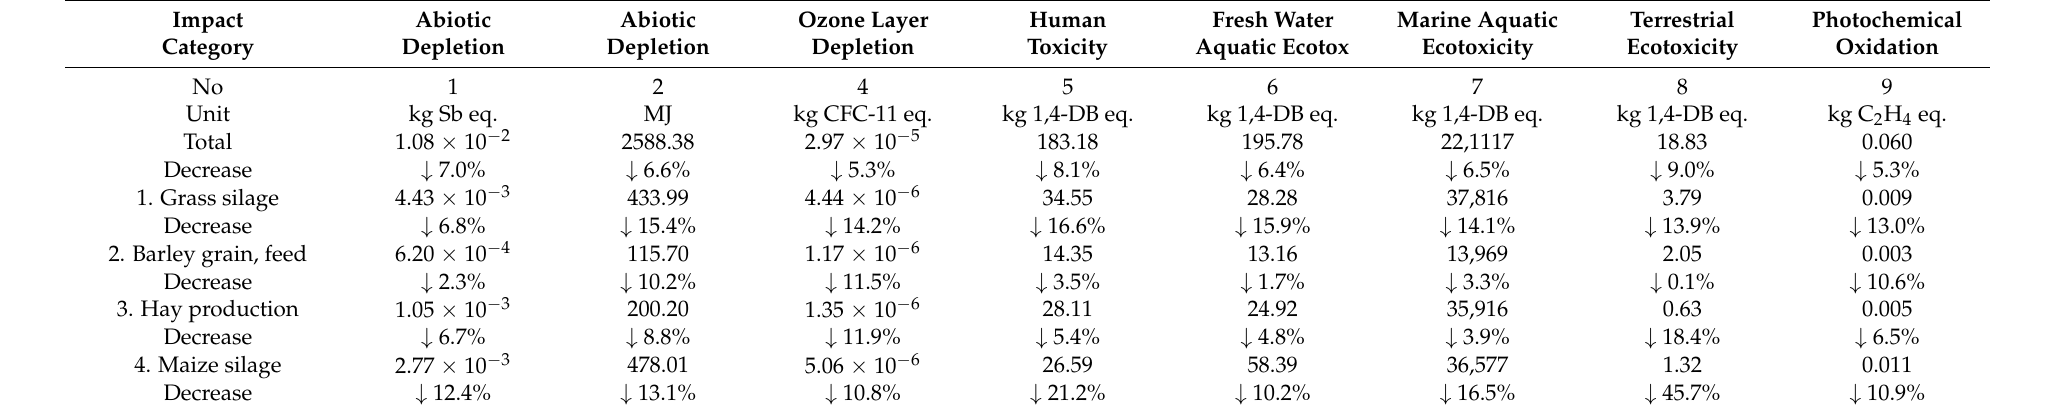
Table 4. Environmental impact of other Bio SC impact categories (for FU = 1000 kg of